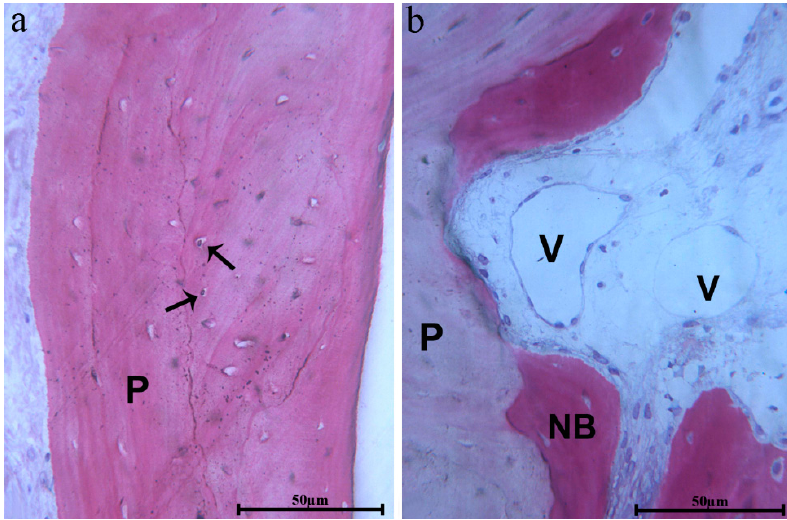
Figure 8. Histologic views: ( a ) some osteocytic lacunae of biomaterial block (P) appear to be filled by cells (black arrows); ( b ) close to the newly formed bone (NB) and biomaterial block (P), many blood vessels (V) are present. (Acid fuchsin-Toluidine blue 200X). At 2-year control CBCT, no signs of inflammation and bone resorption were observed at the grafted sites and around implants (Figure 9).